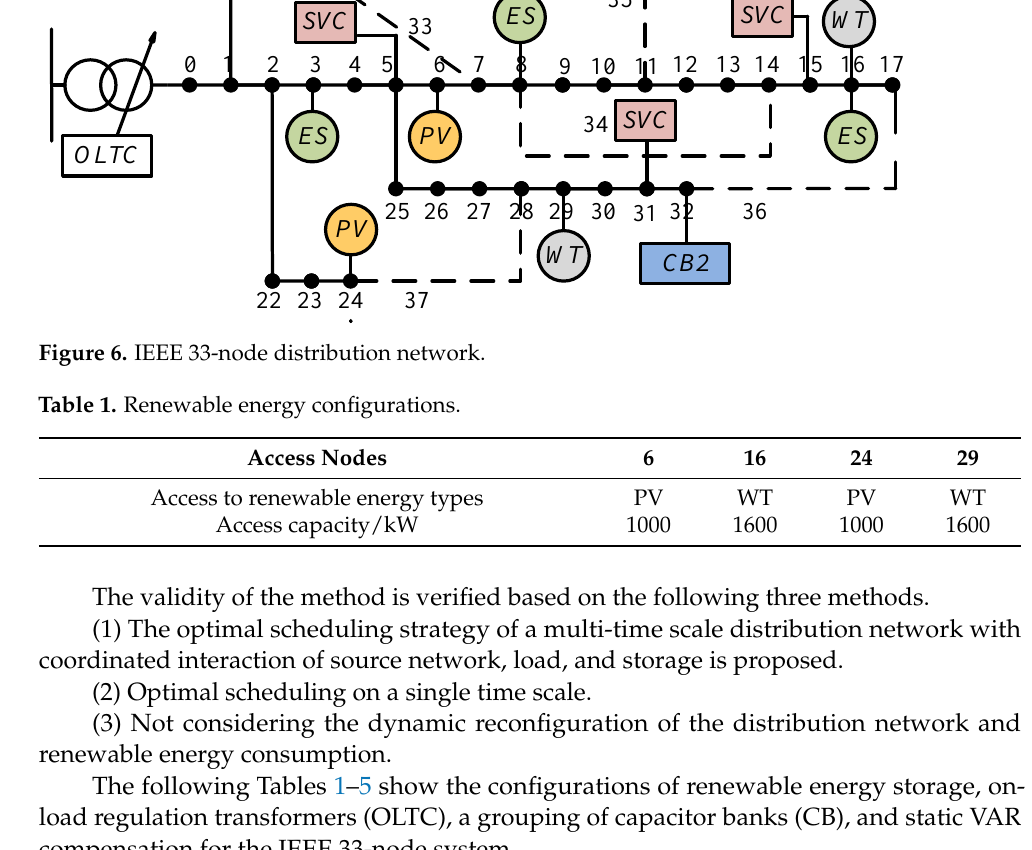
Table 1. Renewable energy configurations.